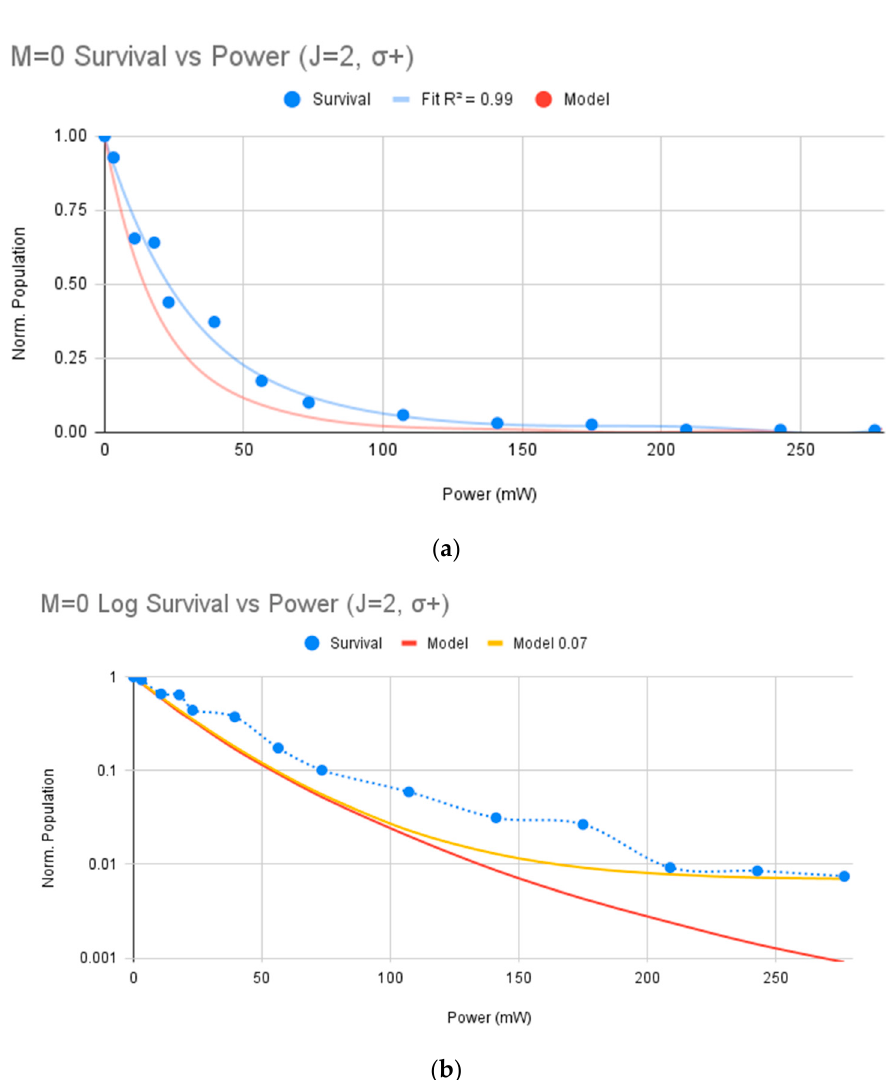
Figure 16. Preparation laser survival ratio (1 µm, σ +/left) vs. power: ( a ) linear plot and base model; ( b ) log plot and 0.07 rad misalignment model.